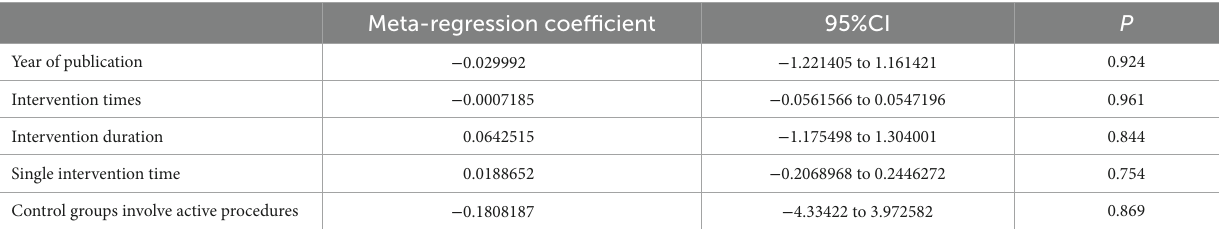
TABLE 2 Meta-regression analysis of potential moderators MoCA to explain heterogeneity of older people with cognitive